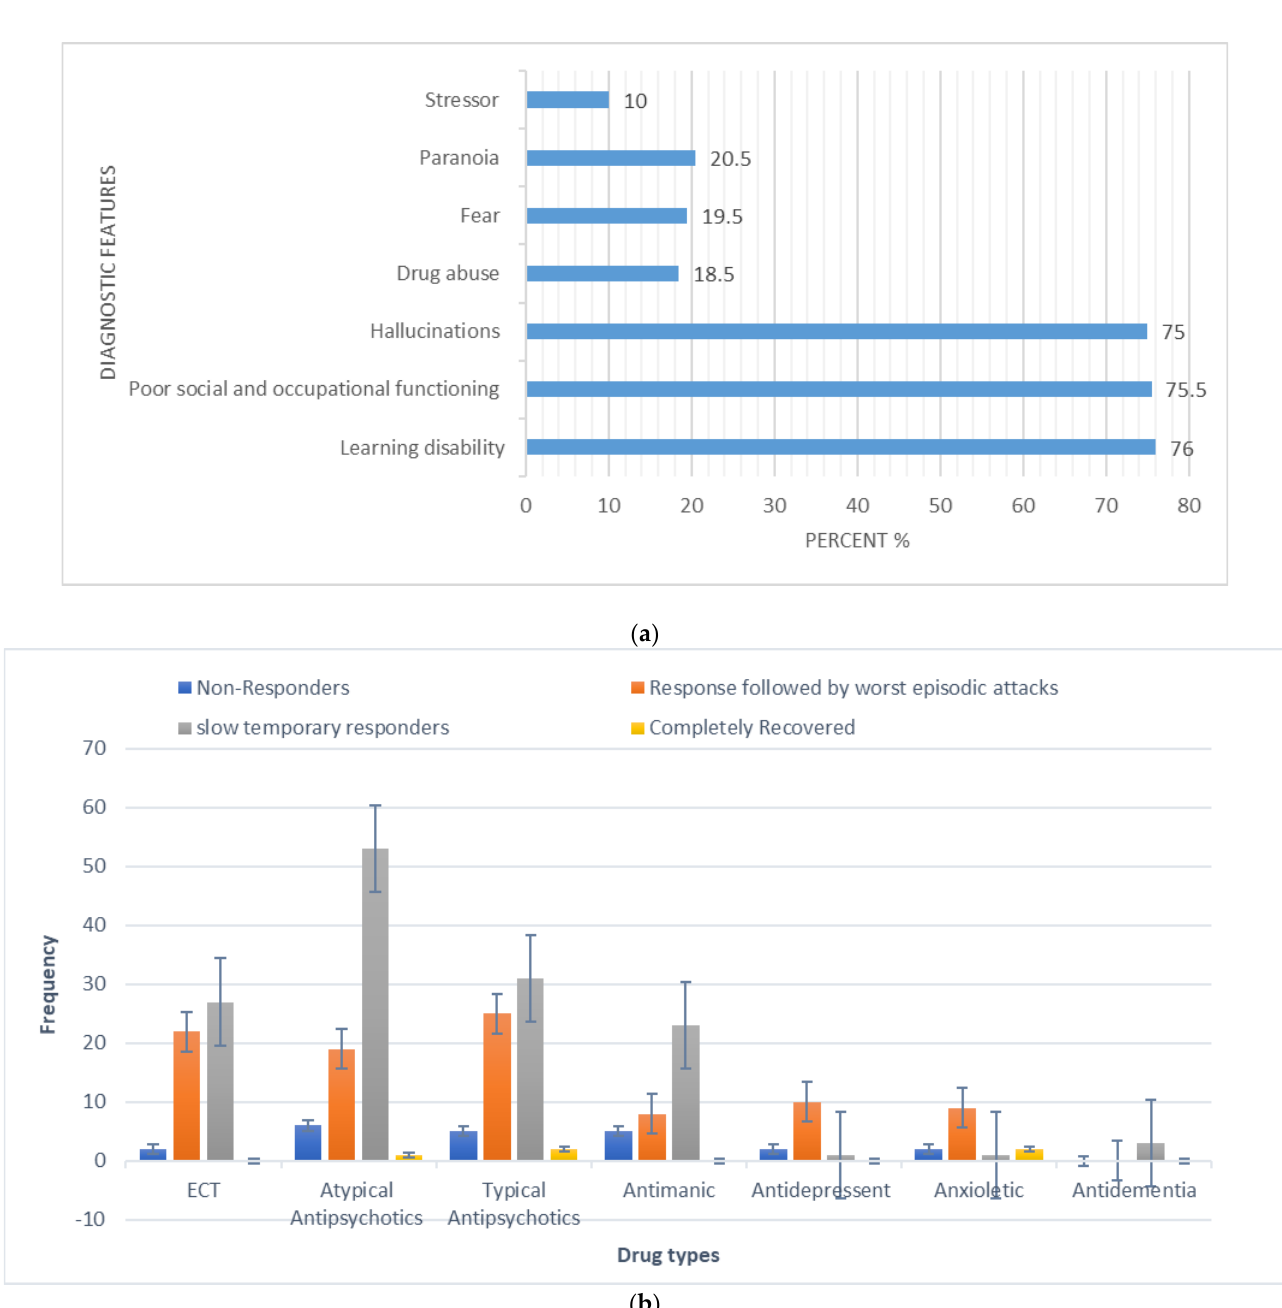
Figure 1. ( a ) Frequency (%) of diagnostic (core) features in the studied schizophrenia sample (N = 200). ( b ) Categorization of responses to polypharmacy treatments given to schizophrenia patients in the studied sample (X-axis represents the different types of drugs and Y-axis represents the frequency of occurrence).